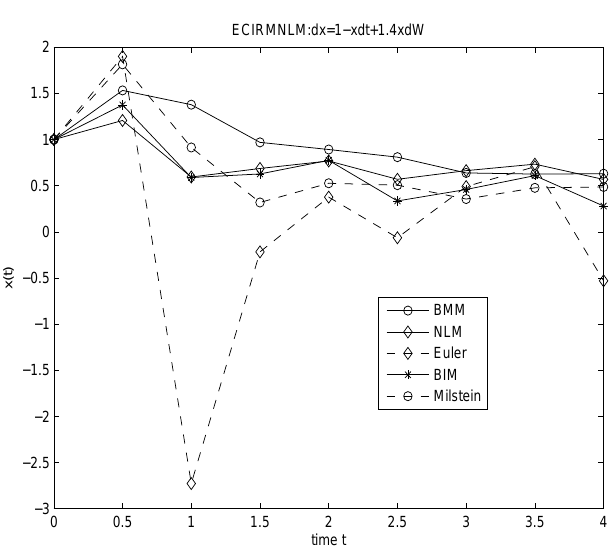
Figure 3. Numerical simulation for the equation: dx = ( 1 − x ) dt + 1.4 xdW , the time interval: [0,4],